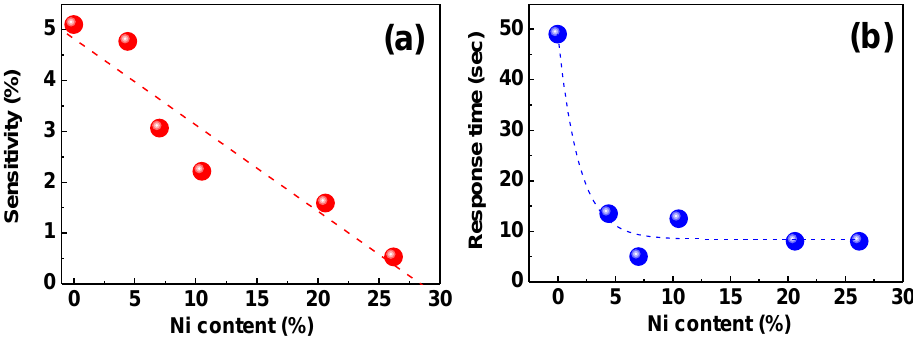
Figure 5. (a) Sensitivity and (b) response time of Pd-Ni alloy films as a functions of Ni content in the presence of 1% H at room temperature. Data reproduced from Lee et al . 2